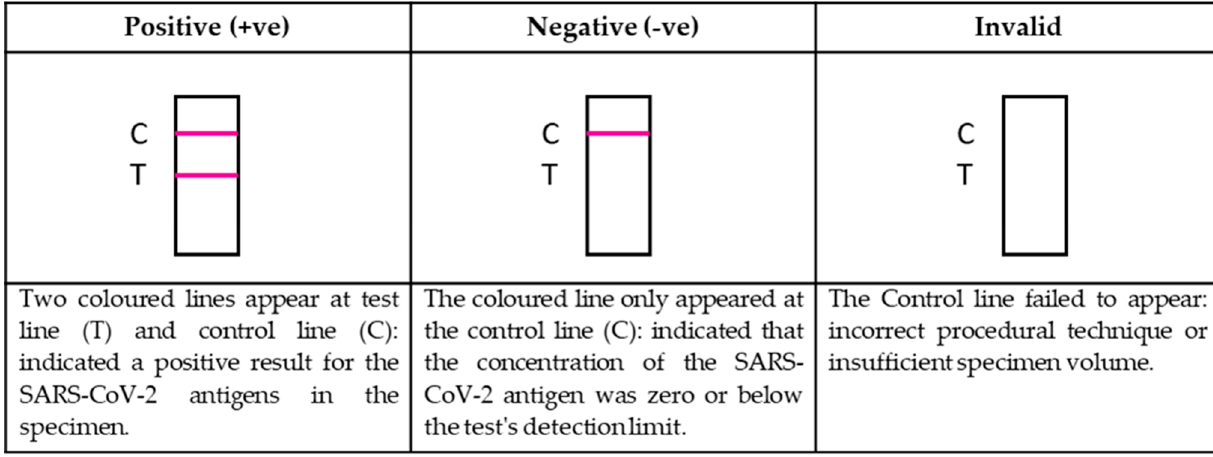
Figure 1. Interpretation and Reporting of Results.